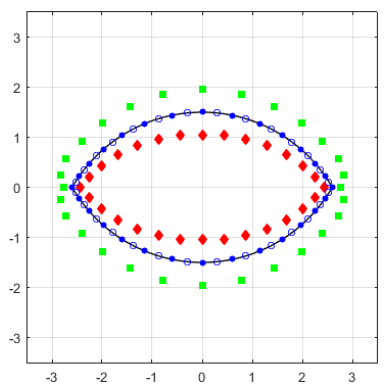
Figure 4. Deformation of the auxiliary surface, combined with densification in the vicinity of the tips: all inner ASs are allowed to approach the CPs, whereas only 1/4 of the outer ASs are allowed to do so.